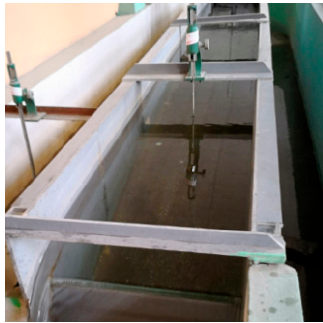
Figure 3. Point gauge and sharp-crested weir.